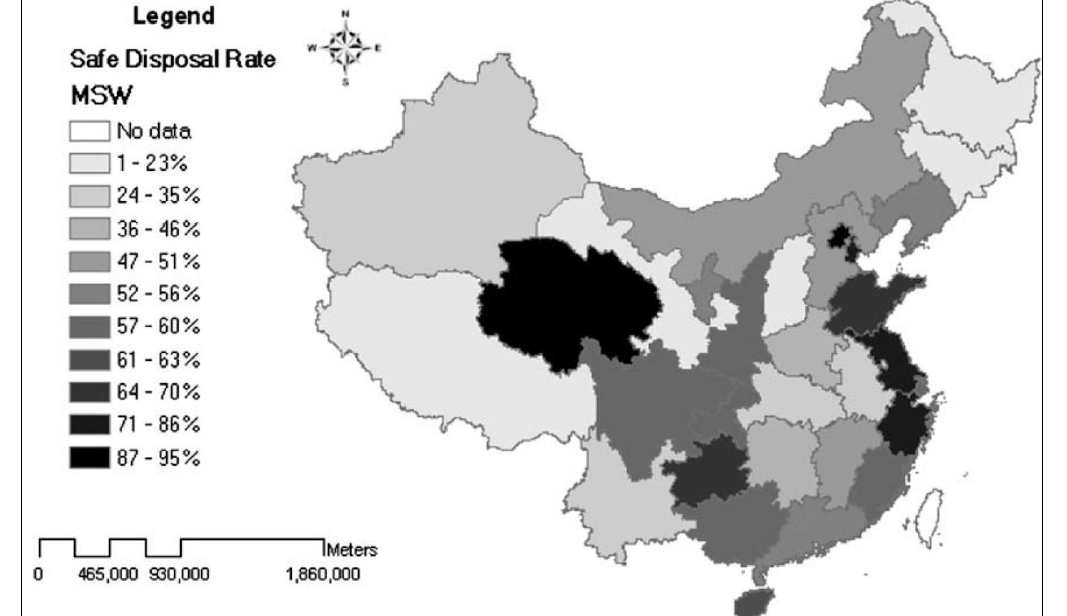
Fig. 13. Safe disposal rates of municipal solid waste (MSW) at the provincial level (2007) (Source: Chen et al.,